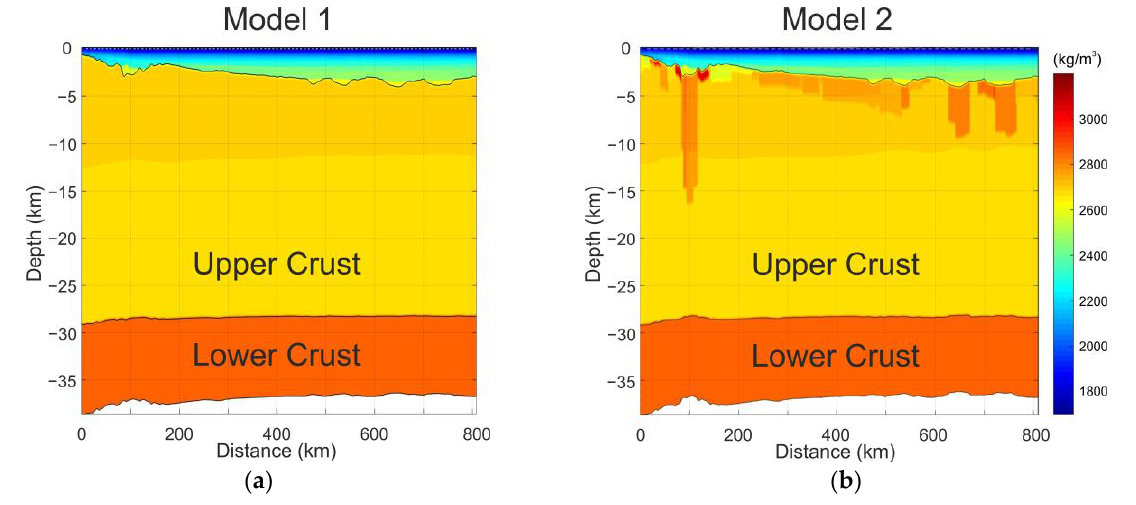
Figure 8. Present-day distribution of bulk density in the crust and basin domains: ( a ) Model 1 and ( b ) Model 2. The density colour code applies to both images. The layer of the lithospheric mantle is not displayed for the convenience of presenting the picture.